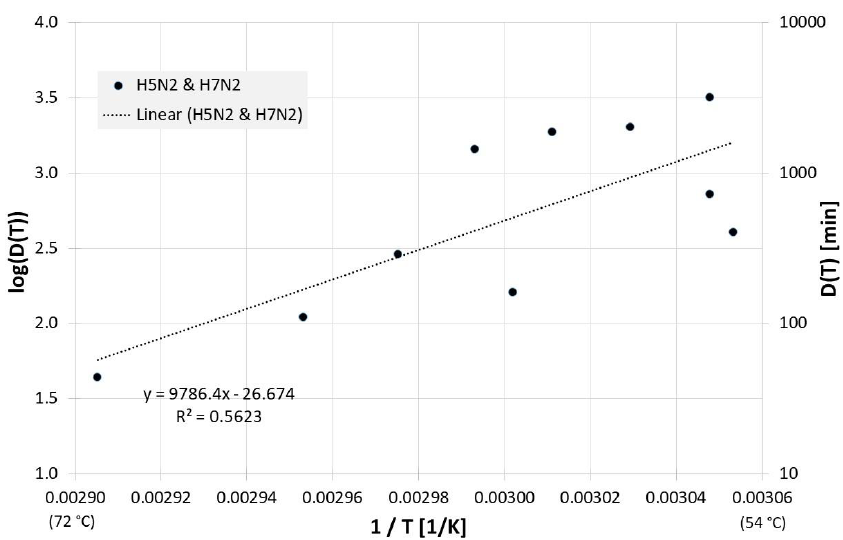
Figure 8. Correlation between 1/T and log(D(T)) for all published influenza virus thermal inactivation data in dried egg white along with the linear regression curve. For better understanding, D(T) is also given on the right Y-axis in a logarithmic scale.